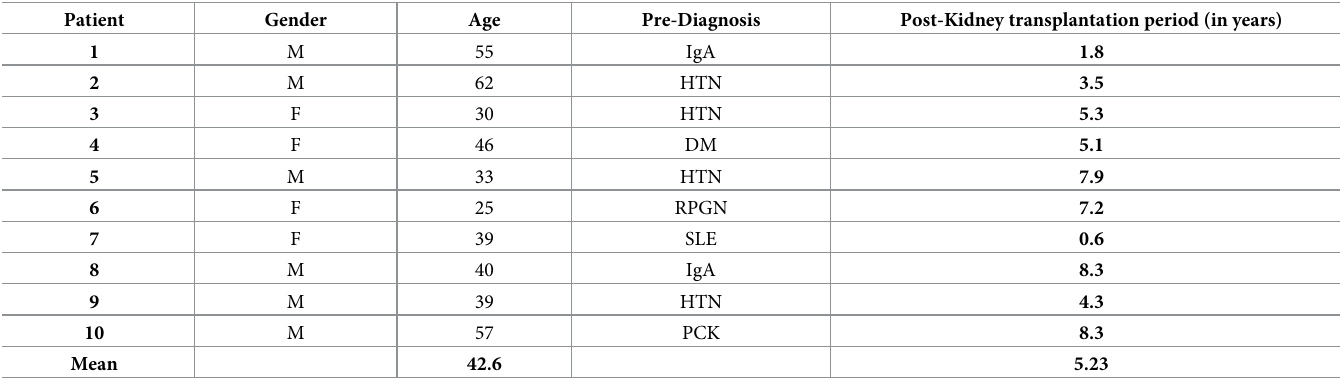
Table 1. Participant characteristics (N =